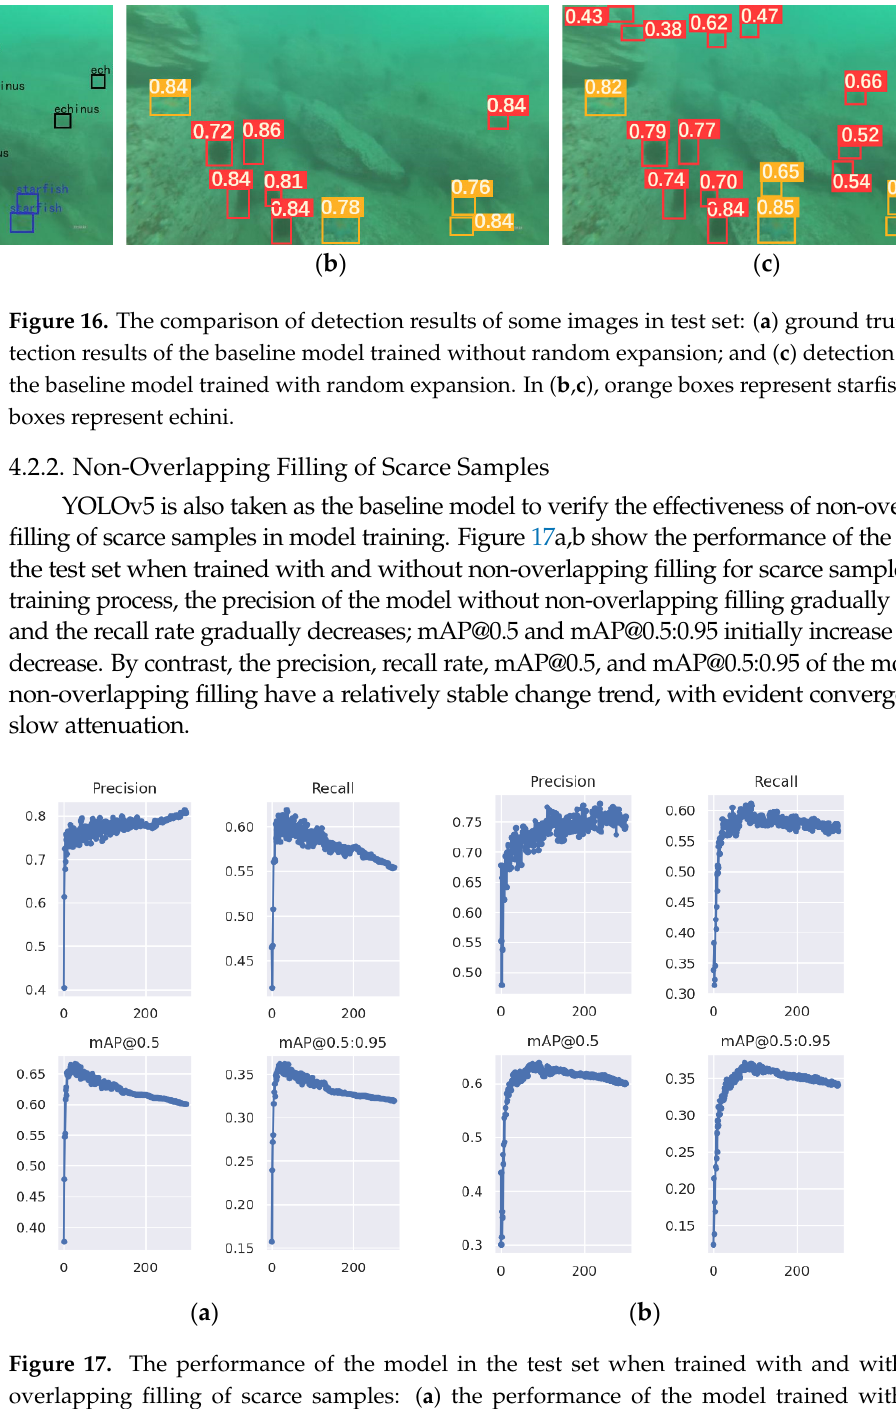
Figure 17. The performance of the model in the test set when trained with and without non-over- lapping fi lling of scarce samples: ( a ) the performance of the model trained without non-overlapping fi lling; and ( b ) the performance of the model trained with non-overlapping fi lling.